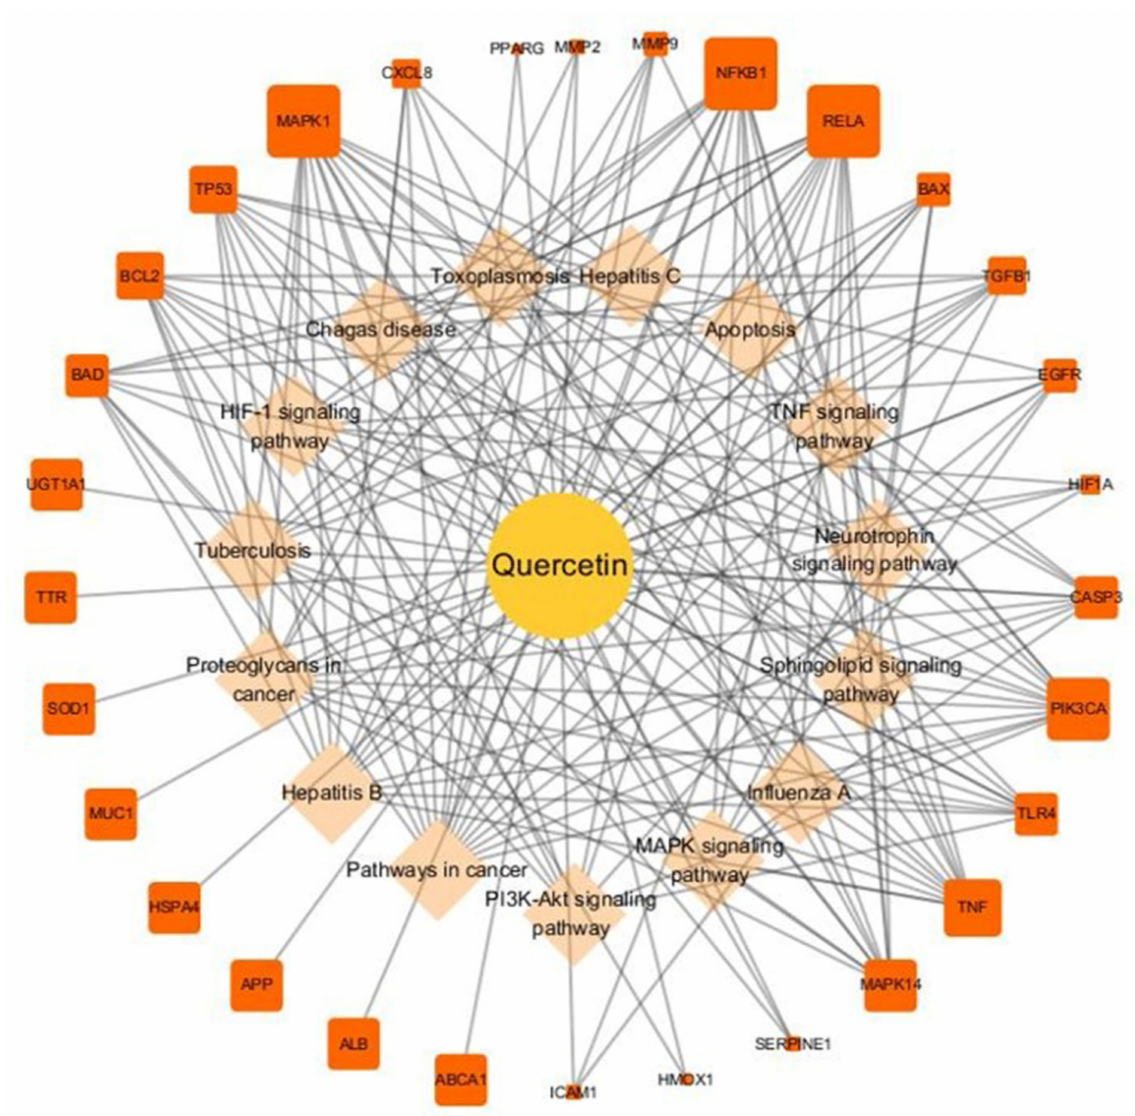
Figure 2. Compound–disease–target–pathway (C-D-P) network. The network has 46 nodes and 186 edges. Among the target nodes, MAPK1, NFKB1, and RELA showed the highest degree of 14. The size of target nodes (dark orange) corresponds to the number of